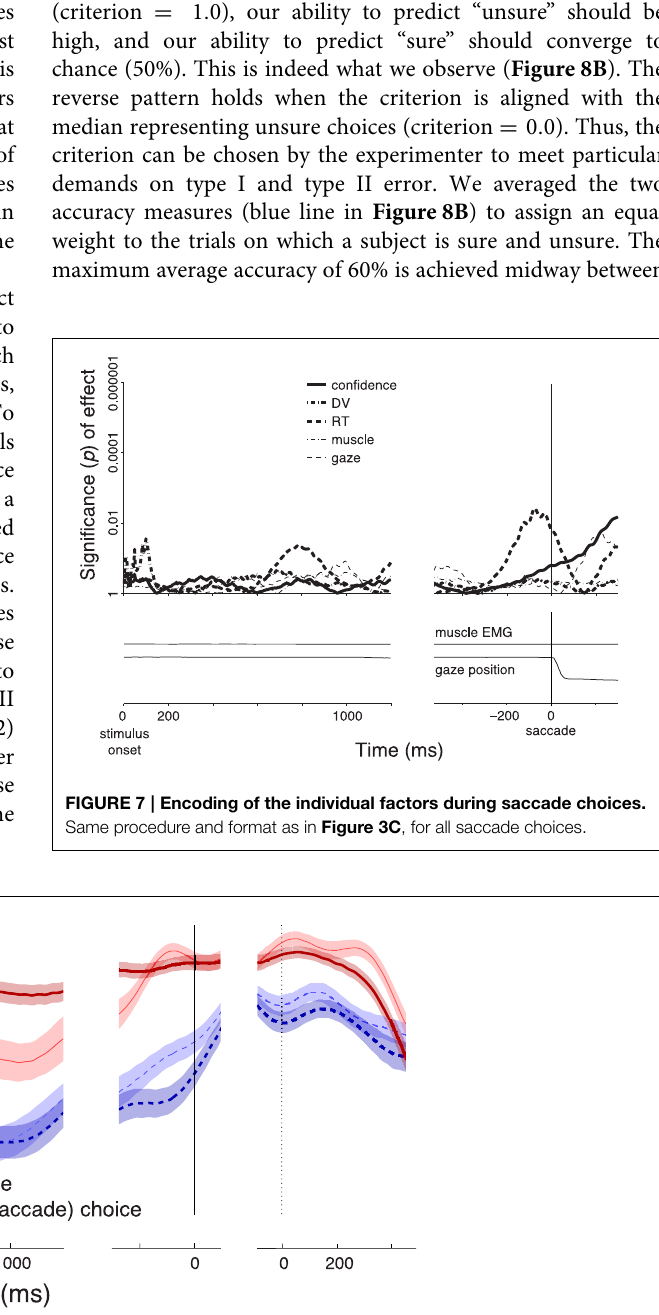
Frontiers in Neuroscience |